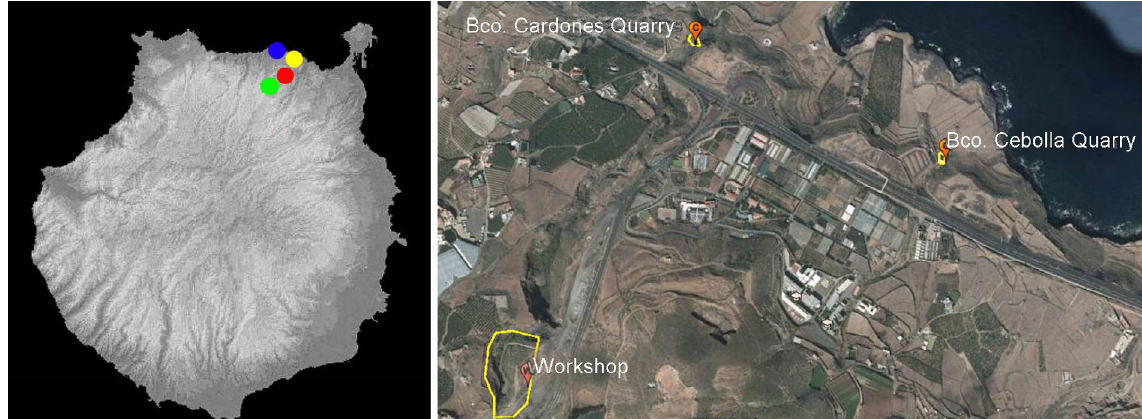
Figure 4. Location of the three quern working sites mentioned in the text. The two along the coast (blue and yellow) are quarries (Cantera Bco Cardones and Cantera de Bco Cebolla). The third is a settlement (red) with a quern workshop. The fourth point (green) marks the Cerera Cave, an inland settlement with the largest known proportion of vesicular basalt querns in the current archaeological record. (Right image from Google Earth). [Download a KML file with the location of the Cantera Bco Cardones and Cantera de Bco Cebolla quarries for viewing in Google Earth and similar